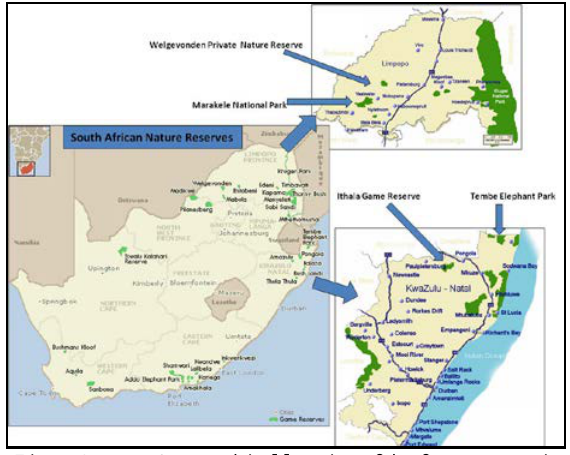
Figure 2: Geographical location of the four reserves in South Africa